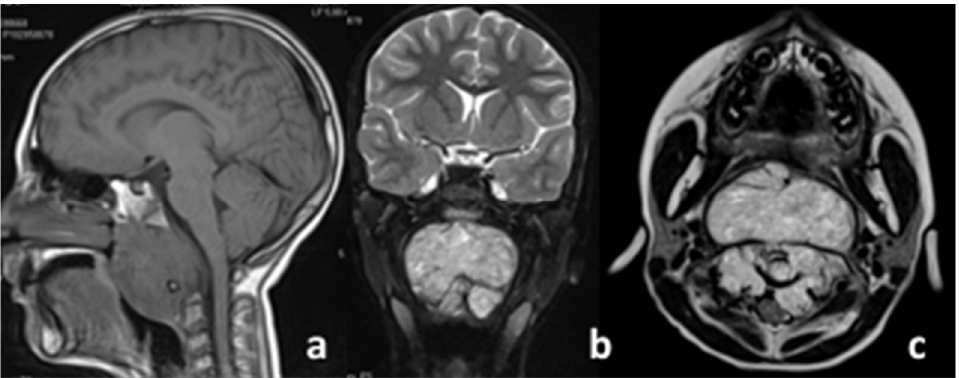
Figure 1. Imaging at diagnosis: ( a ) sagittal view, ( b ) coronal view, ( c ) axial view.